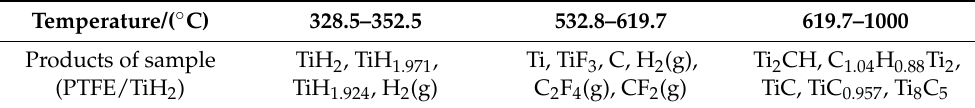
Table 16. Products of PTFE/TiH 2 composites in different temperature ranges under argon